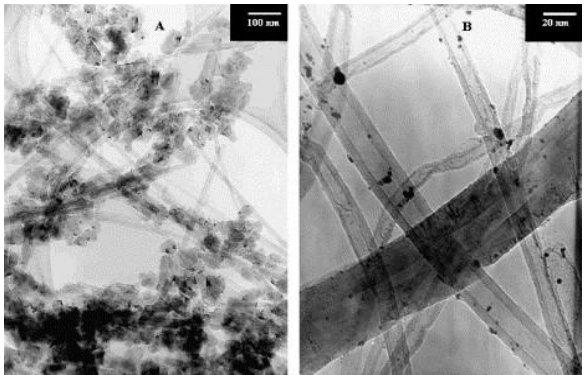
Figure 6. Pt catalysts supported on carbon nanotubes